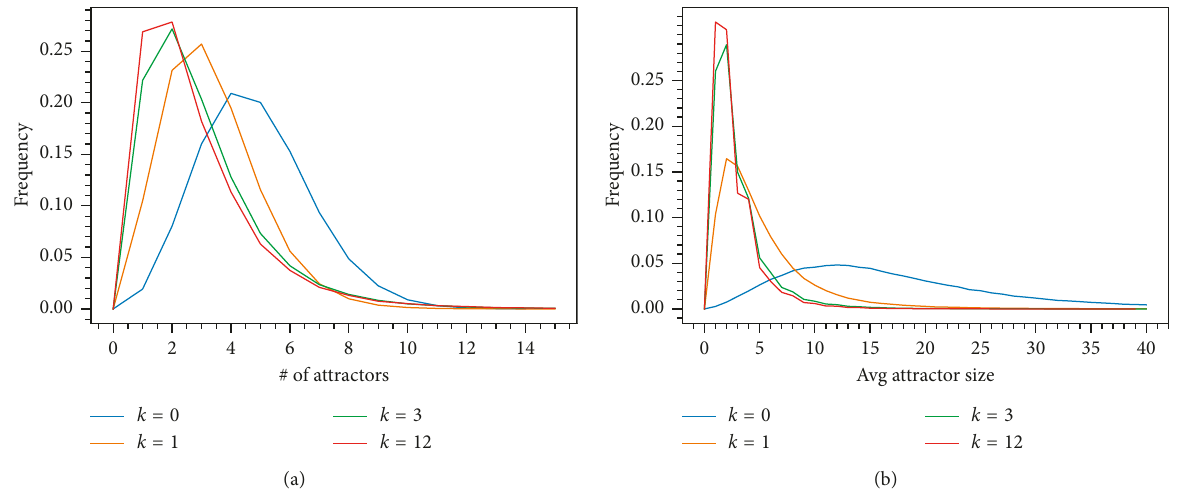
Figure 2: Empirical distributions of N ( f ) and AS ( f ) for n � 12 and k � 0 , 1 , 3 , 12. (a) Distribution of the number of attractors N ( f ) . (b) Distribution of the average size of an attractor AS ( f )